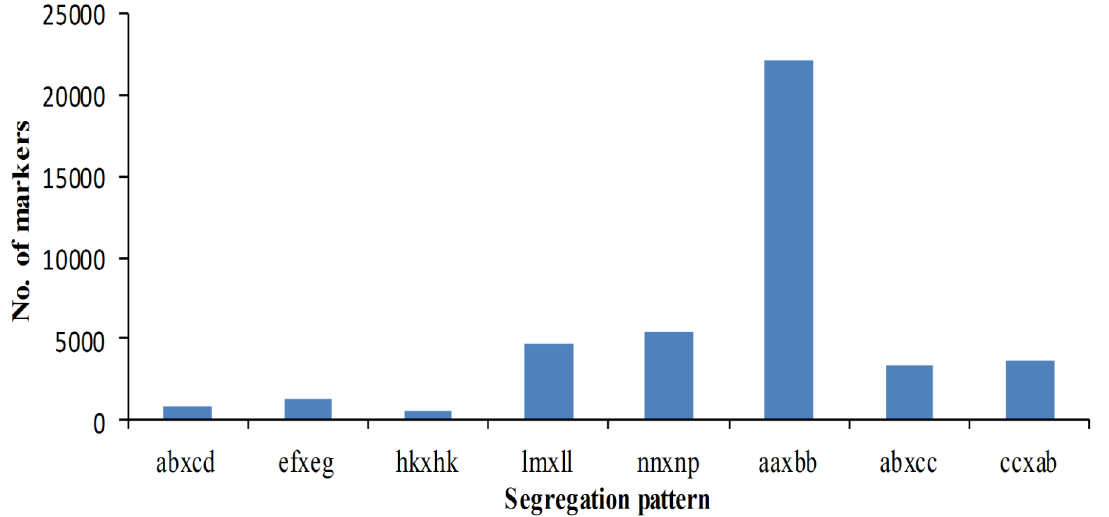
Fig 2. Distribution of SLAF markers in eight segregation patterns.